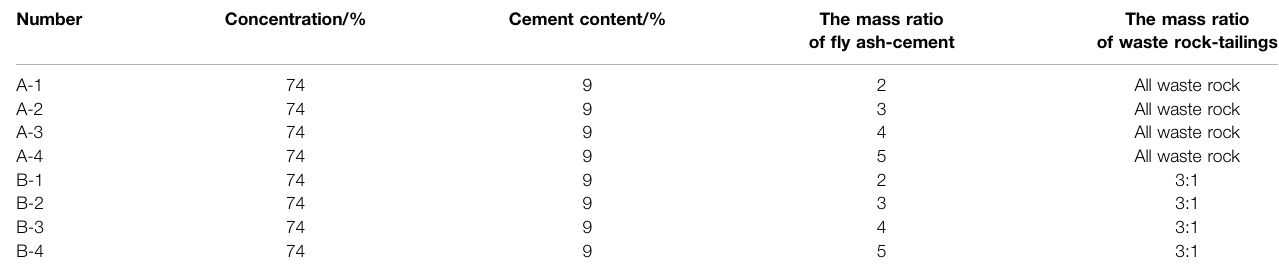
TABLE 2 | Experiments of the fl y ash on the effect of back fi ll